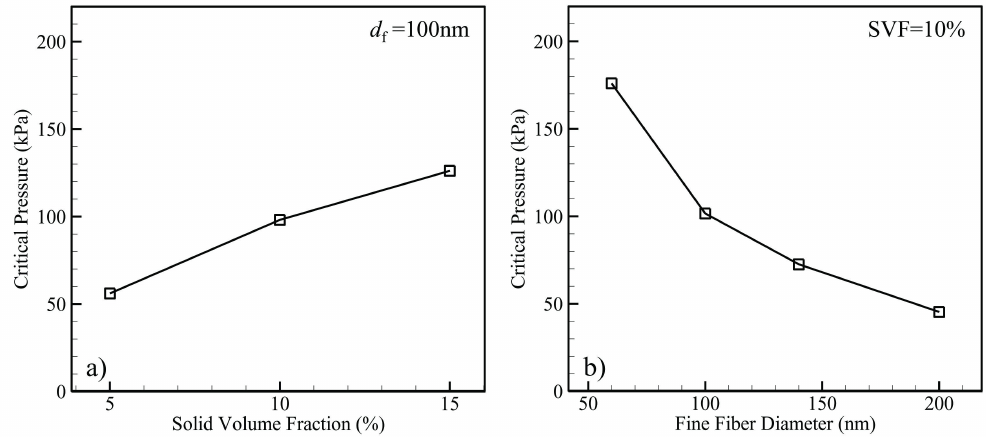
Figure 31. Critical pressure predictions for layered, randomly oriented media compared against variations in one of four microstructural parameters. ( a ) Solid volume fraction; ( b ) fiber diameter. For both ( a ) and ( b ), coarse-to-fine fiber diameter ratio ( R coarse number fraction ( n ) = 0.1. Figure adapted from Bucher et al. c